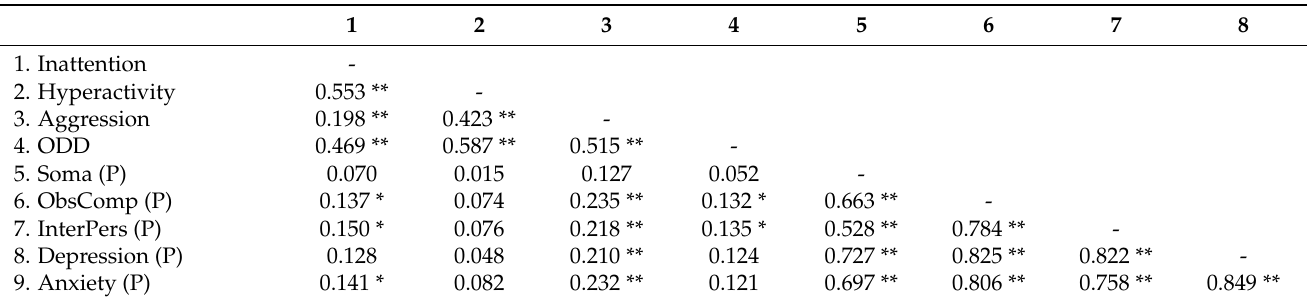
Table 2. Zero-order correlations among study